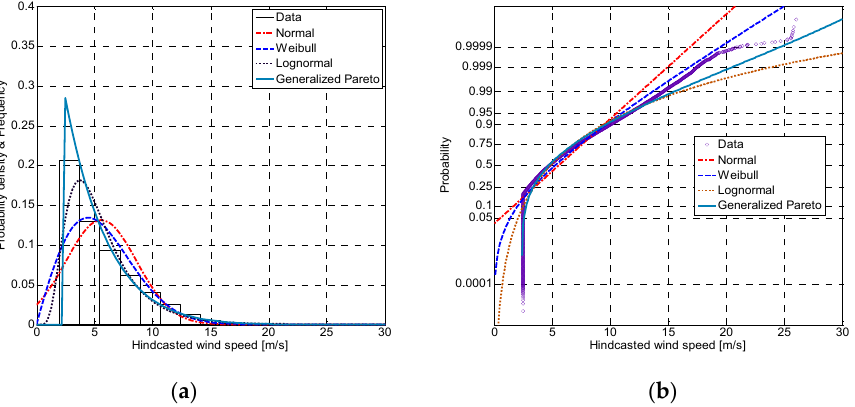
Figure 1. (a) Comparison of PDFs and (b) goodness of fit test results of used data. Figure 1. ( a ) Comparison of PDFs and ( b ) goodness of fit test results of used